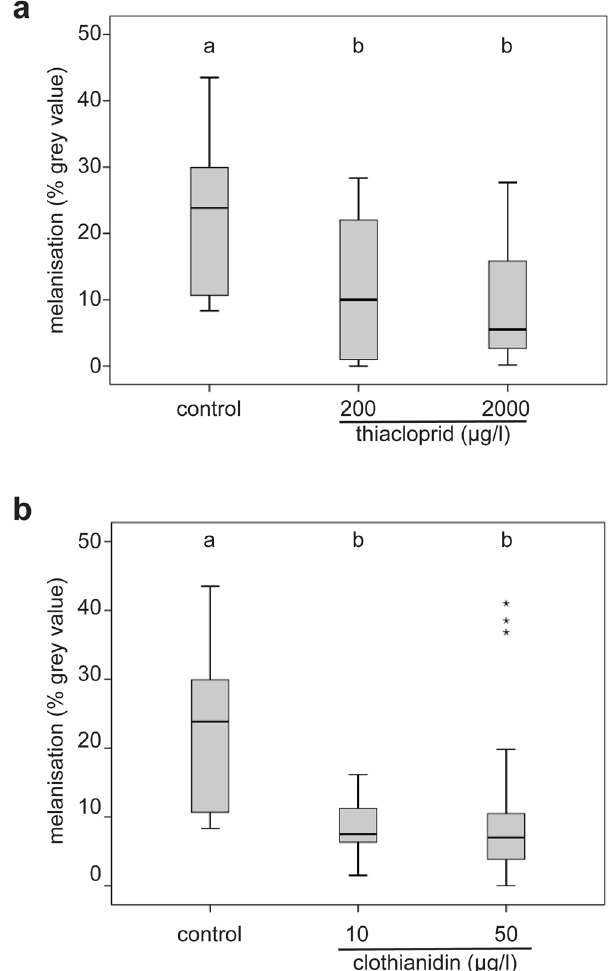
Figure 3. Exposure to thiacloprid or clothianidin reduced melanisation response. The seven day-exposure of young honeybee queens to thiacloprid (( a ); control: n = 20, 200 µ g/l: n = 17, 2000 µ g/l: n = 15), or clothianidin (( b ); control: n = 20; 10 µ g/l: n = 19; 50 µ g/l: n = 18) reduced the melanisation of an implanted nylon filament compared to control queens. Boxes show 1st and 3rd interquartile range with black lines denoting medians. Whiskers encompass 95% of the individuals, beyond which outliers (asterisks) reside. Treatments with different letters differ significantly from each